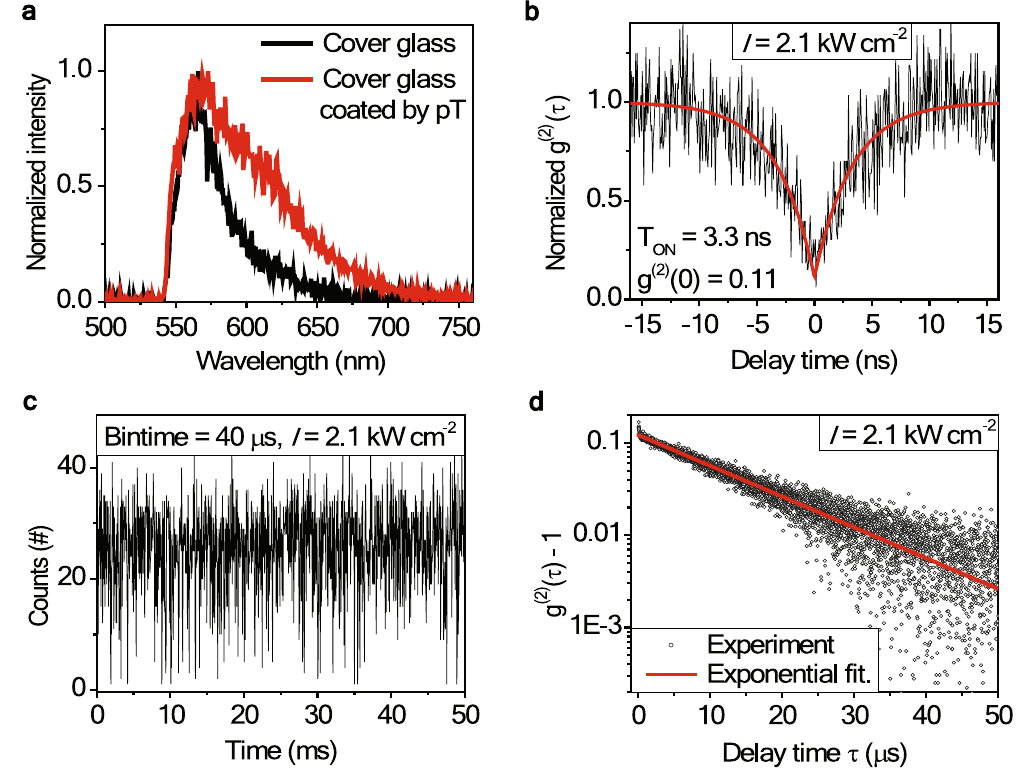
Figure 4. Silica defect center (DC) on cover glasses coated with a para-terphenyl crystal layer. ( a ) Spectral comparison of DCs from a bare cover glass (black curve) and from a cover glass coated with pT crystal (red curve). ( b ) Normalized g (2) ( τ ) of a DC from the cover glass coated with pT crystal at short time scale. It shows a good anti-bunching nature with g (2) (0) = 0.11. ( c ) The PL intensity trajectory of DC at excitation intensity I = 2.1 kW/cm 2 . ( d ) A semi-log plot of a long-time g (2) ( τ ) obtained at I = 2.1 kW/cm 2 . An exponential fitting is given in